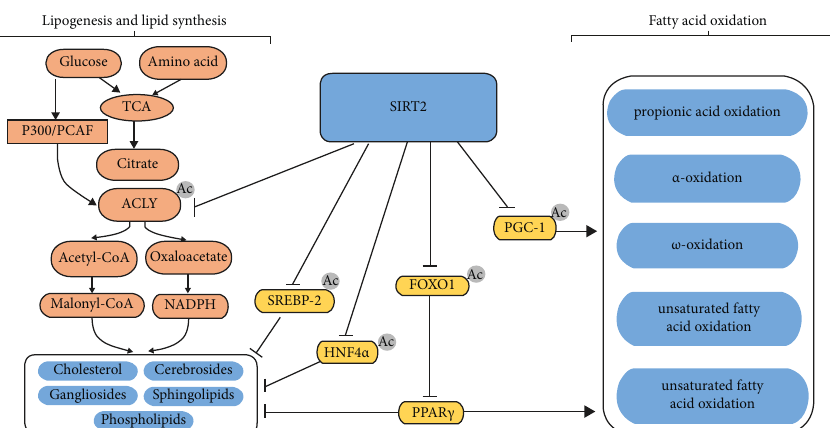
Figure 1: SIRT2 is involved in lipid metabolism. SIRT2 affects lipid synthesis through ACLY. P300/PCAF can stabilize ACLY by acetylation, thereby promoting lipid synthesis. SIRT2 degrades ACLY by deacetylation to inhibit lipid synthesis. SIRT2 promotes the binding of SREBP- 2 to the SRE by promoting the nuclear translocation of SREBP-2, thereby promoting the transcription of cholesterol synthesis-related genes and ultimately promoting the synthesis of cholesterol. SIRT2 inhibits lipid synthesis by deacetylating HNF4 α . SIRT2 promotes fatty acid oxidation and inhibits lipid synthesis by inhibiting the nuclear translocation of FOXO1. In addition, SIRT2 promotes fatty acid oxidation through the deacetylation of